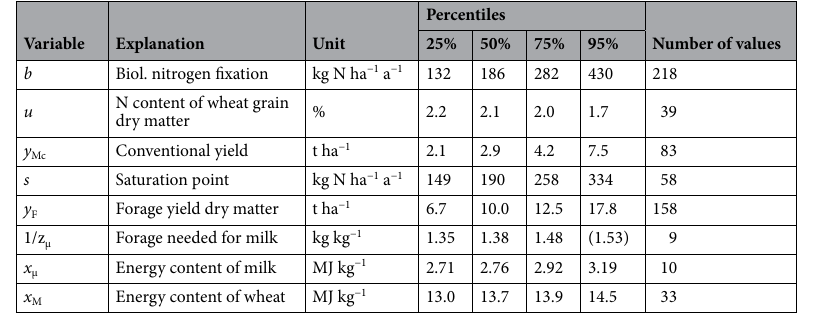
Table 1. Input data used for